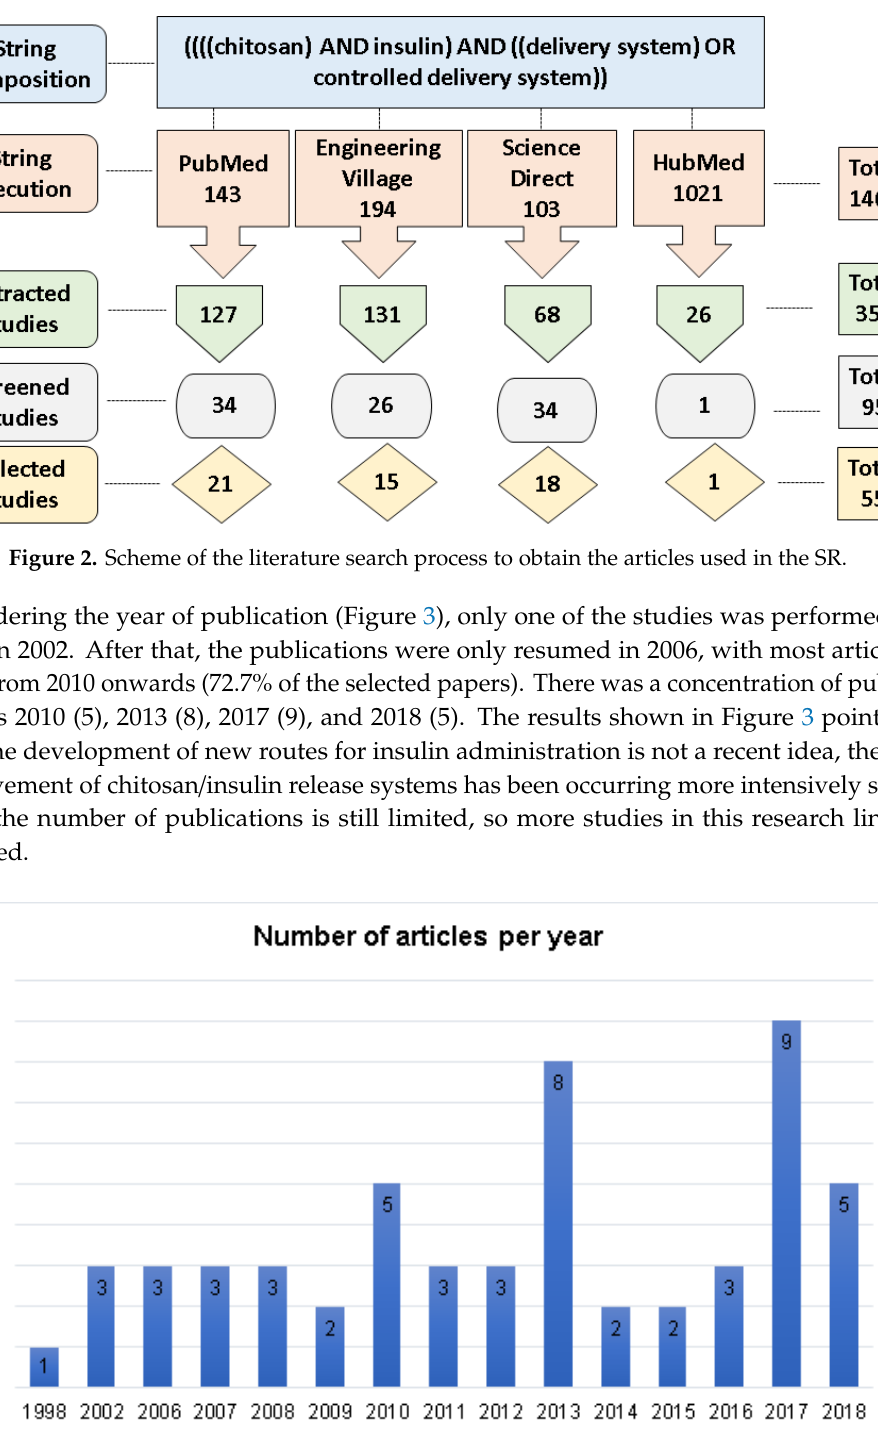
Figure 3. General view of the number of publications per year.